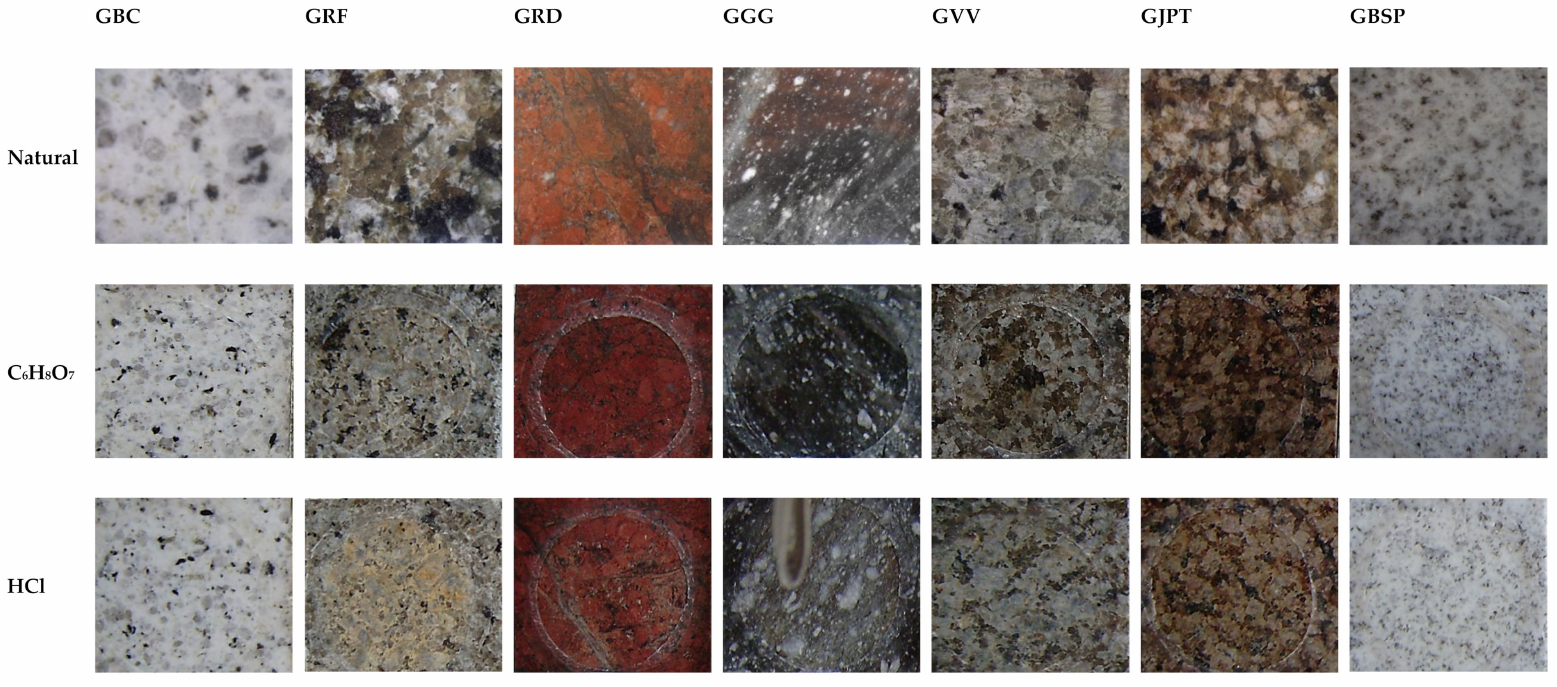
Figure 9. Samples of granite stones before and after exposure to citric acid and hydrochloric